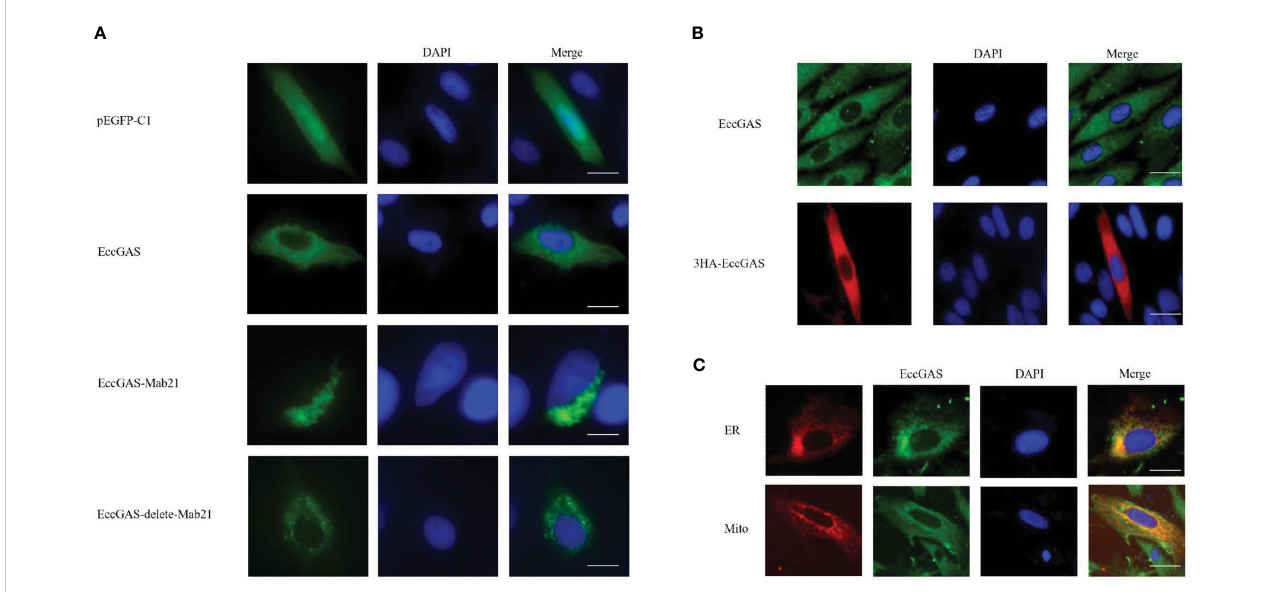
FIGURE 4 Cellular localization of EccGAS. (A) Subcellular localization of the EccGAS structural domain Mab21 and the deletion of the structural domain in GS cells. GS cells were transfected with pEGFP-C1, pEGFP-EccGAS, pEGFP-EccGAS-Mab21 and pEGFP-EccGAS-delete-Mab21 plasmids using Liposome 2000. After transfection for 24 h, the cells were fi xed with 4% paraformaldehyde for 2 h at 25 °C, and were stained with DAPI and examined under confocal laser scanning microscopy. Scale bars shown as 20 µm. (B, C) Immuno fl uorescence and colocalization with endoplasmic reticulum and mitochondria. GS cells were inoculated and transfected with pcDNA3.1-EccGAS or pDsRed2-ER and pDsRed2-Mito, primary antibody with rabbit polyclonal anti-EccGAS antibody (1:150) or mouse monoclonal anti-HA antibody (1:150) incubated for 2 h at 25 °C and secondary antibody with FITC-conjugated goat anti-rabbit or goat anti- mouse (1:200). Subsequently, the cells were incubated for 1 h and examined by confocal microscopy. Scale bars are shown as 20